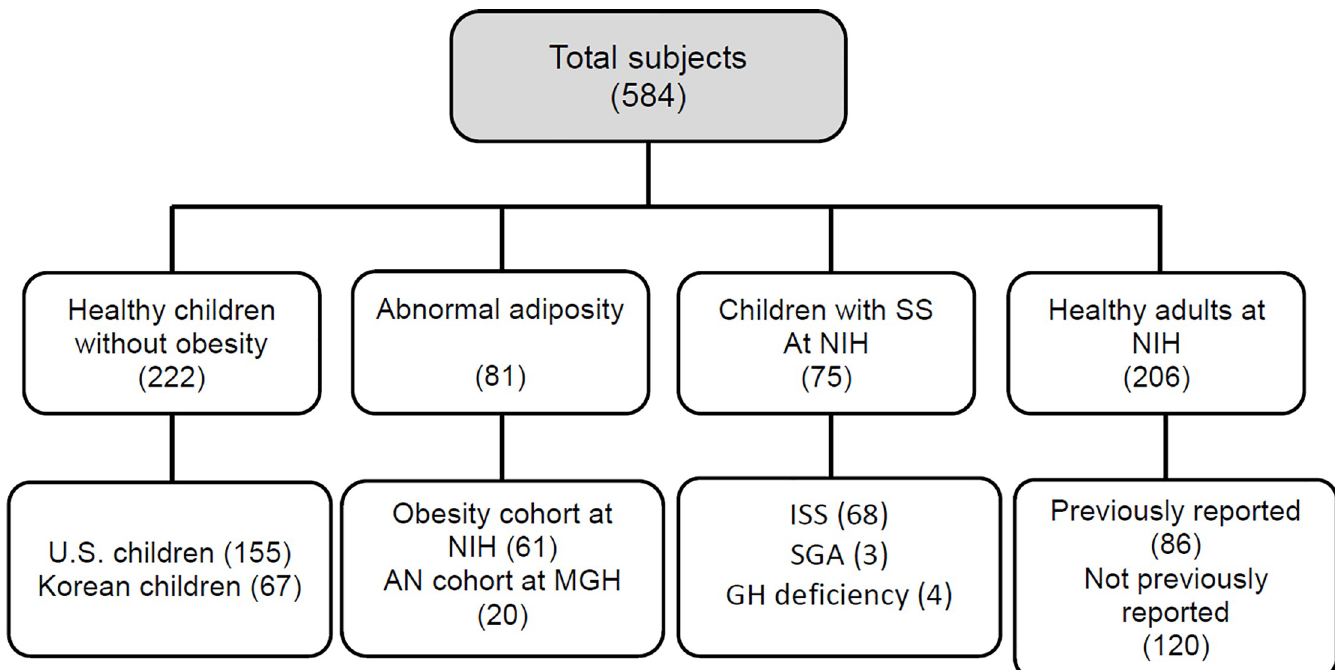
Fig 1. Subject groups. Healthy children without obesity, children and young adults with abnormal adiposity (obesity and anorexia nervosa), children with short stature, and healthy adults were studied. Numbers of subjects in each group are shown in parentheses. SS, short stature; AN, anorexia nervosa; ISS, idiopathic short stature; SGA, small for gestational age; GH, growth hormone; NIH, National Institutes of Health; MGH, Massachusetts General Hospital; U.S., United States (studied at NIH).